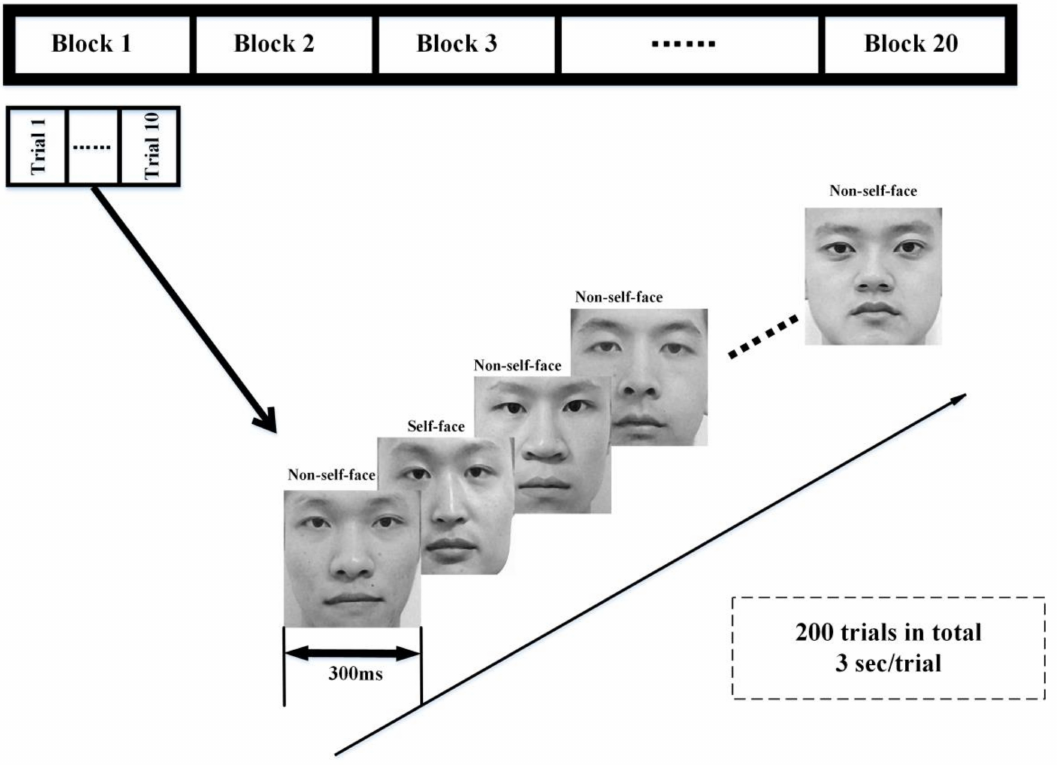
Figure 4. Flowchart of the self- or non-self-face RSVP